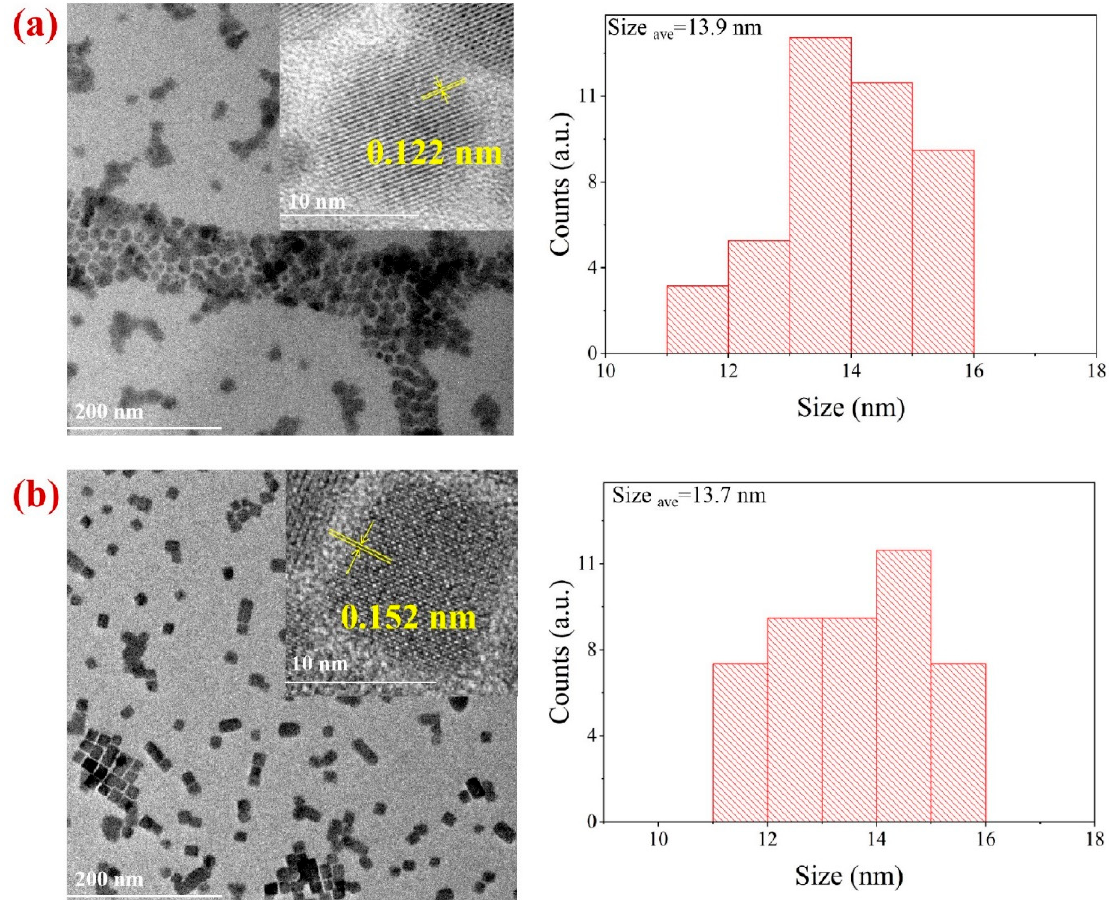
Figure 2. TEM images and size distributions of Cs 4 PbBr 6 ( a ) and CsPbBr 3 NCs ( b ).